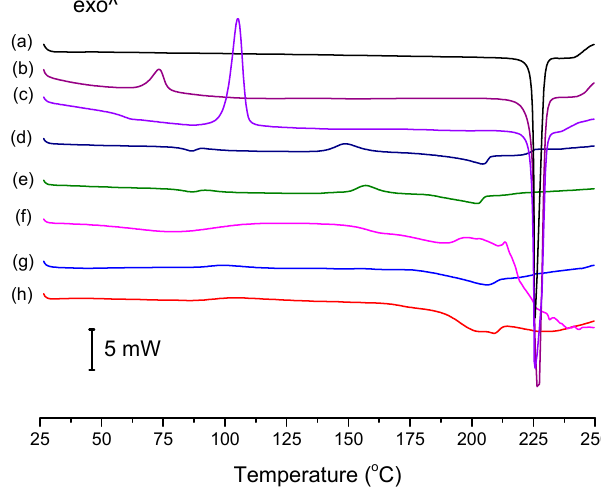
Figure 4. Di ff erential scanning calorimetry (DSC) thermograms of (a) crystalline ENRO, (b) ball milled Figure 4. Differential scanning calorimetry (DSC) thermograms of ( a ) crystalline ENRO, ( b ) ball ENRO,(c)quenchcooledENRO,(d)ENRO / HPMCAS-MG,(e)ENRO / HPMCAS-LG,(f)ENRO / Carbopol, milled ENRO, ( c ) quench cooled ENRO, ( d ) ENRO/HPMCAS-MG, ( e ) ENRO/HPMCAS-LG, ( f ) (g) ENRO / Eudragit L100-55, and (h) ENRO / Eudragit L100. The thermograms of the ASDs are those ENRO/Carbopol, ( g ) ENRO/Eudragit L100-55, and (h) ENRO/Eudragit L100. The thermograms of the obtained from the second heating cycle, following initial heating to 65 ◦ C to allow for residual ASDs are those obtained from the second heating cycle, following initial heating to 65 °C to allow for water residual water removal.